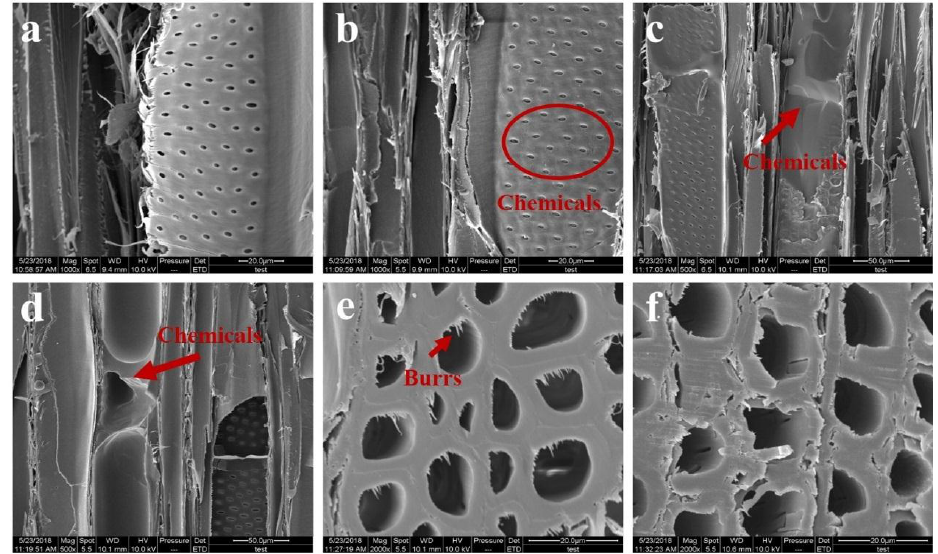
Figure 7. Micrographs of the tangential sections of ( a ) the untreated wood sample and the wood samples treated with ( b ) 10% DM ( c ) 10% DM + 10% MA ( d ), 10% DM + 10% SU (Cross-section) of ( e